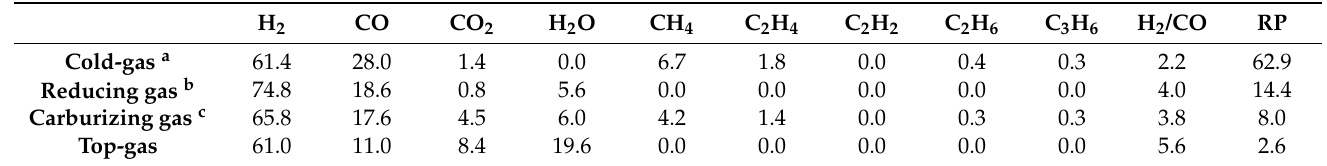
Table 6. Compositions of the cold-gas, reducing gas, carburization gas, and top-gas in the DFB-DR route. Species concentrations are given in volume percent. RP refers to the reduction potential, which is defined as (H 2 + CO)/(H 2 O + CO 2 ). H 2 CO CO 2 Cold-gas a Reducing gas b Carburizing gas c